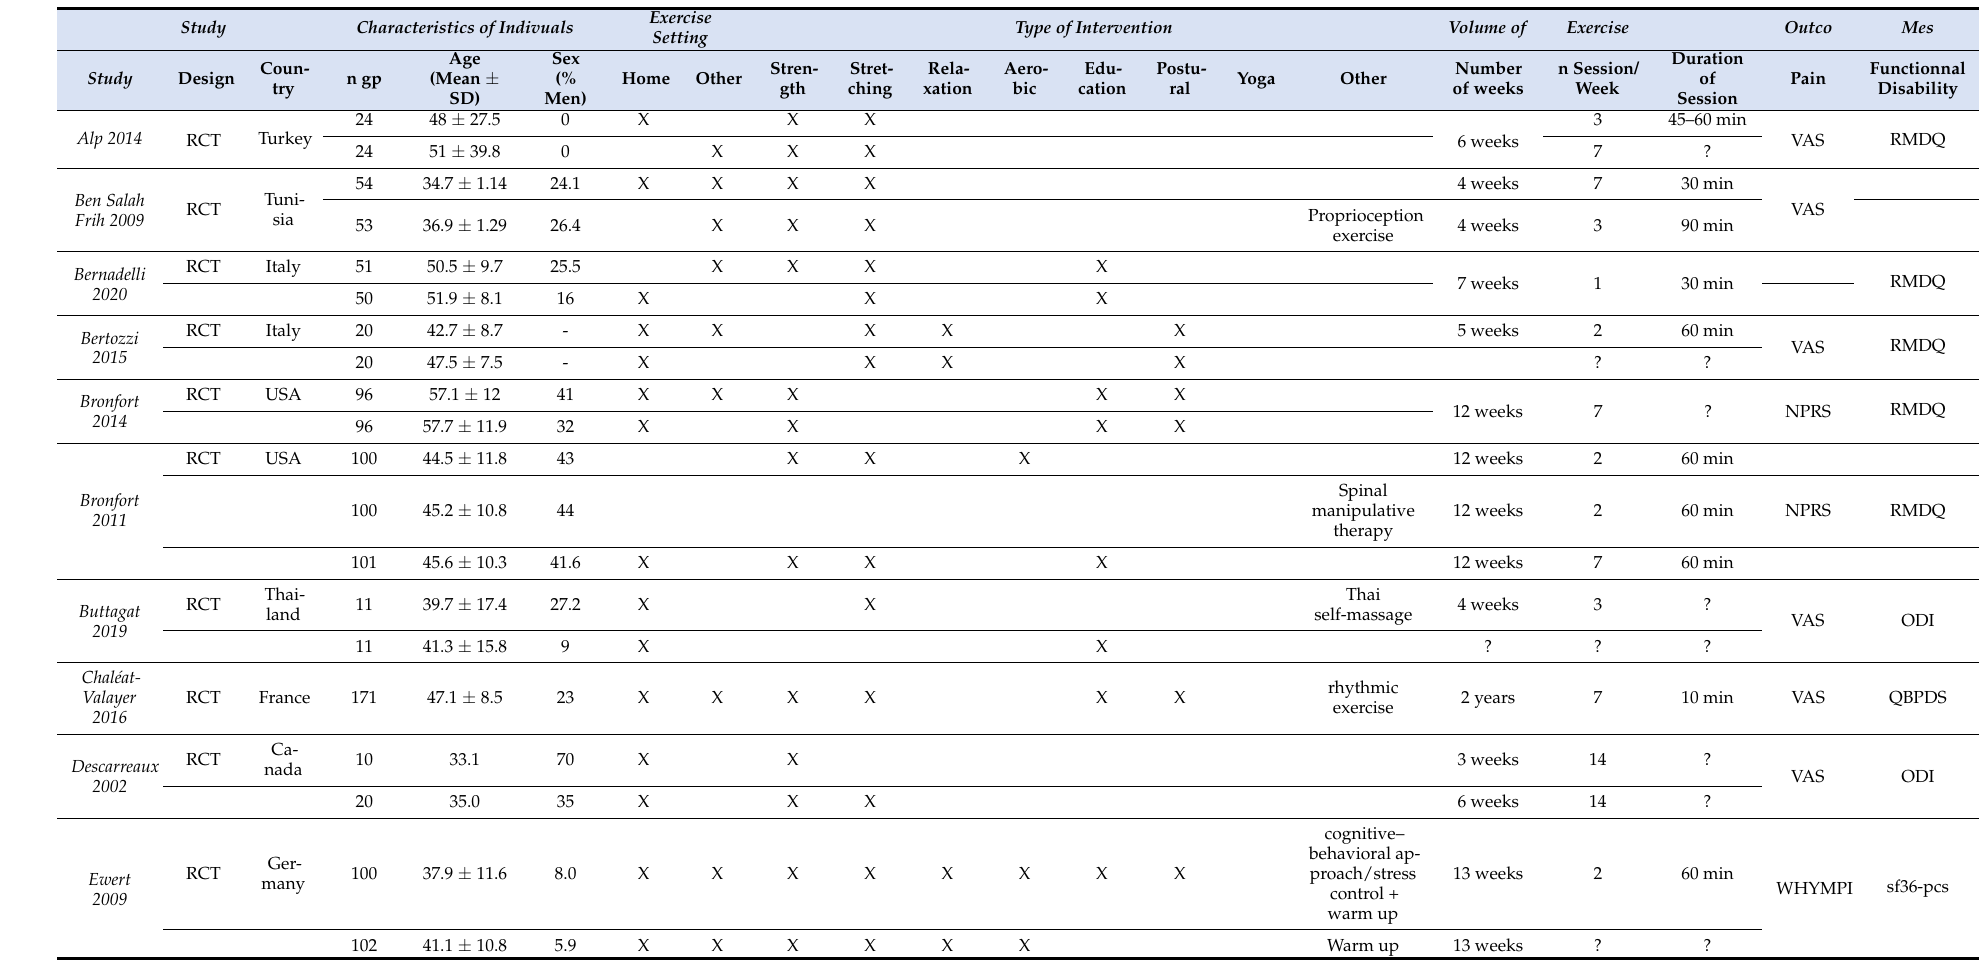
Table 1. Characteristics of included